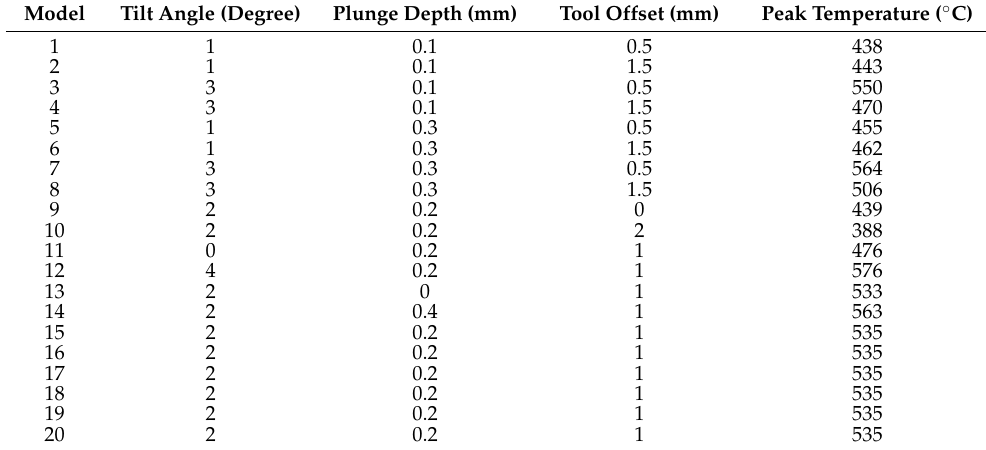
Table 6. Design matrix and response values.